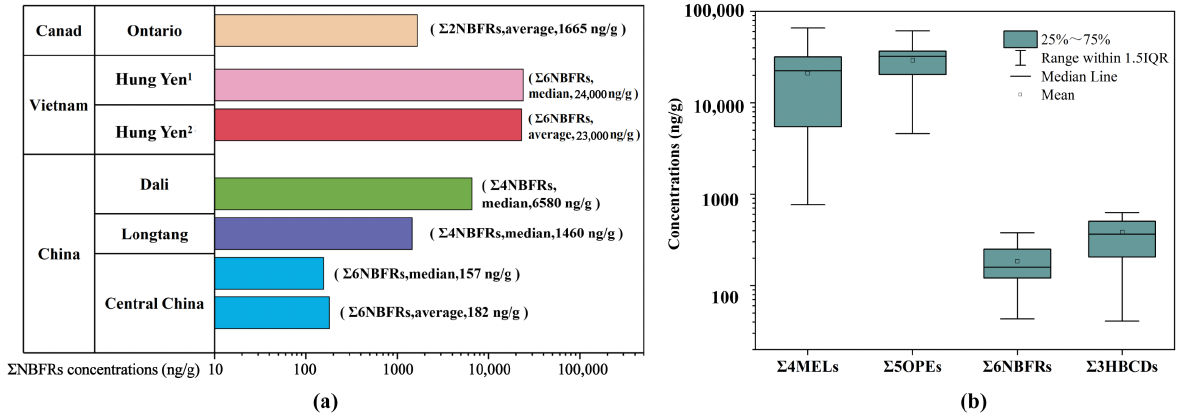
Figure 2. The dust concentrations of NBFRs in e-waste-dismantling workshop from different regions; Hung Yen 1 is the data for samples collected in October 2015, Hung Yen 2 is that in September 2019, Central China is the data from this study ( a ), and the dust concentrations of NBFRs and organophosphate and nitrogenous flame retardants in studied area; IQR means inter-quartile range ( b ).